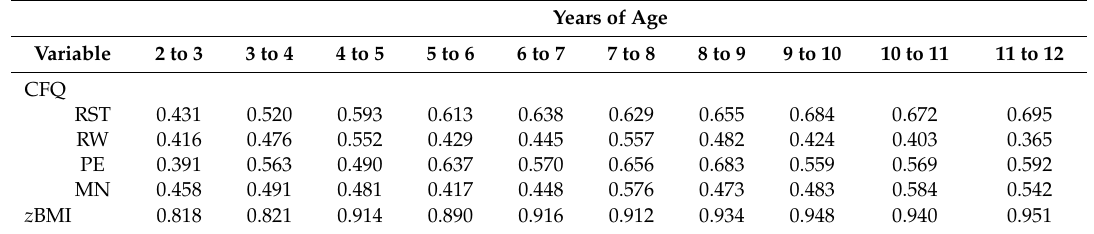
Table 2. Stability of parental feeding practices and standardized child body mass